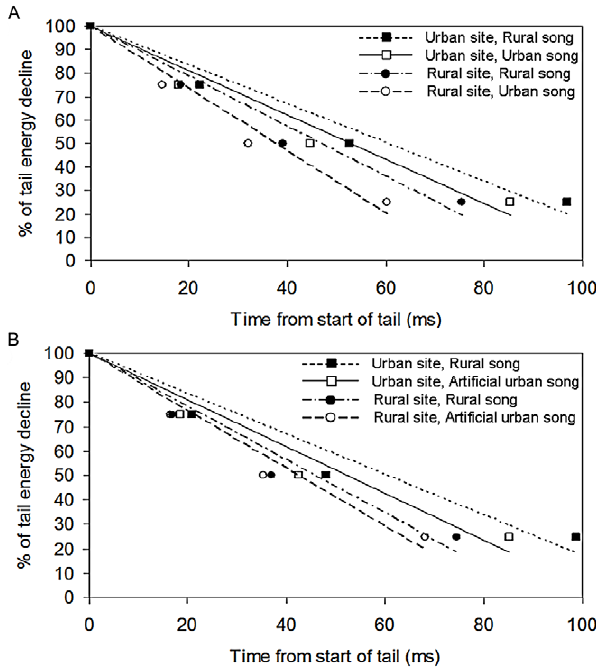
Figure 5. The rate of tail energy decline (RTD) for great tit songs after transmission. RTD of rural, urban & artificial urban songs, i ndicated by regression lines through time points 0, Q1, Q2 and Q3 (energy remaining: 100%, 75%, 50% and 25% respectively) for